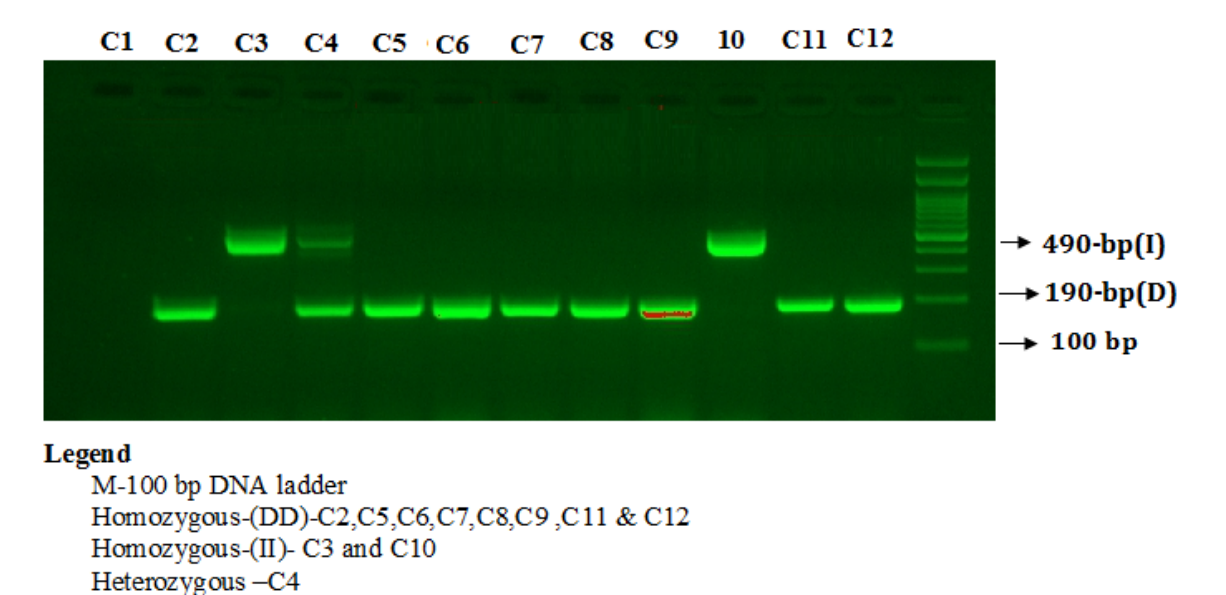
Figure 1. Detection of Angiotensin I ‐ converting enzymes (ACE2) insertion/deletion (I/D) rs4343 gene polymorphism.